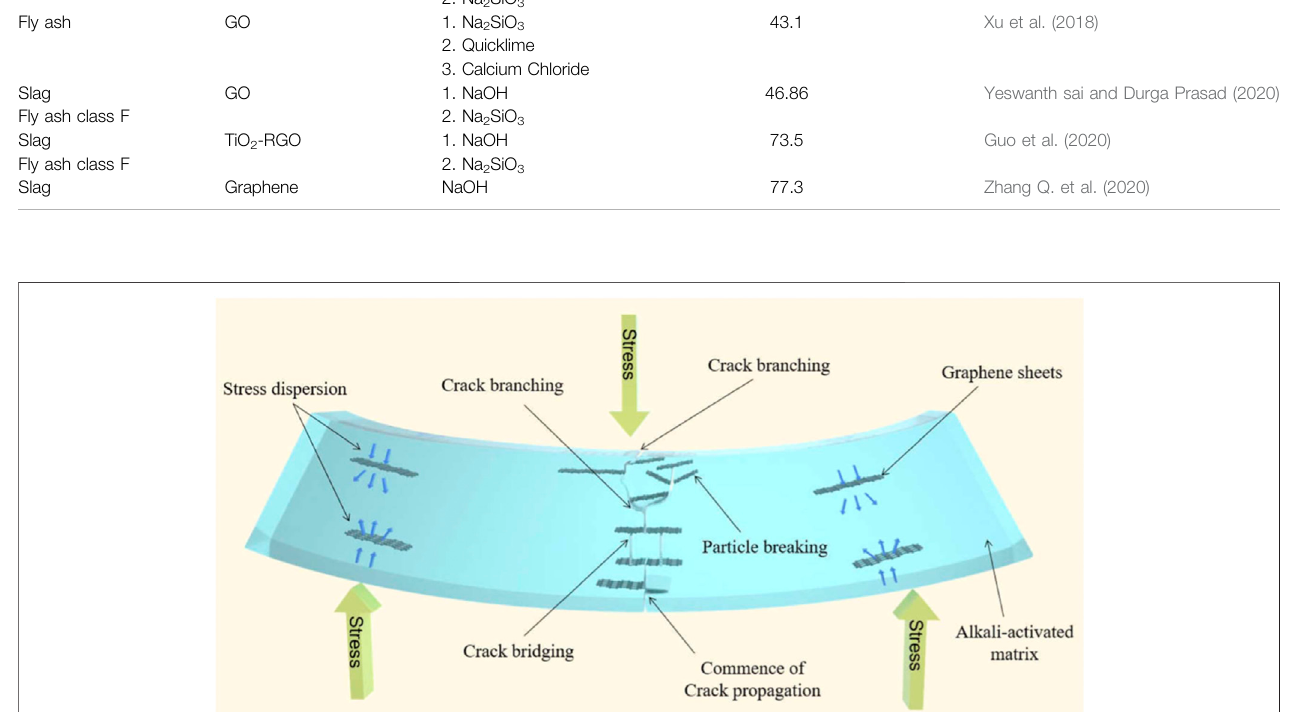
FIGURE 5 | Schematic diagram of toughening mechanism due to bending load applied on the graphene/geopolymer nanocomposite (Guo et al., 2020).